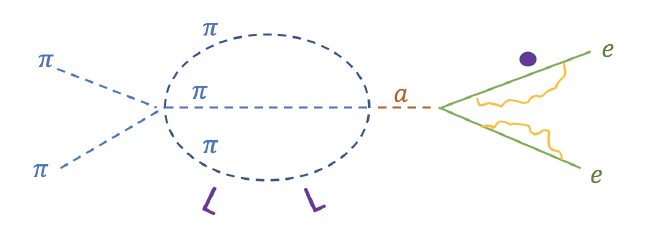
Figure 9: The crocodile